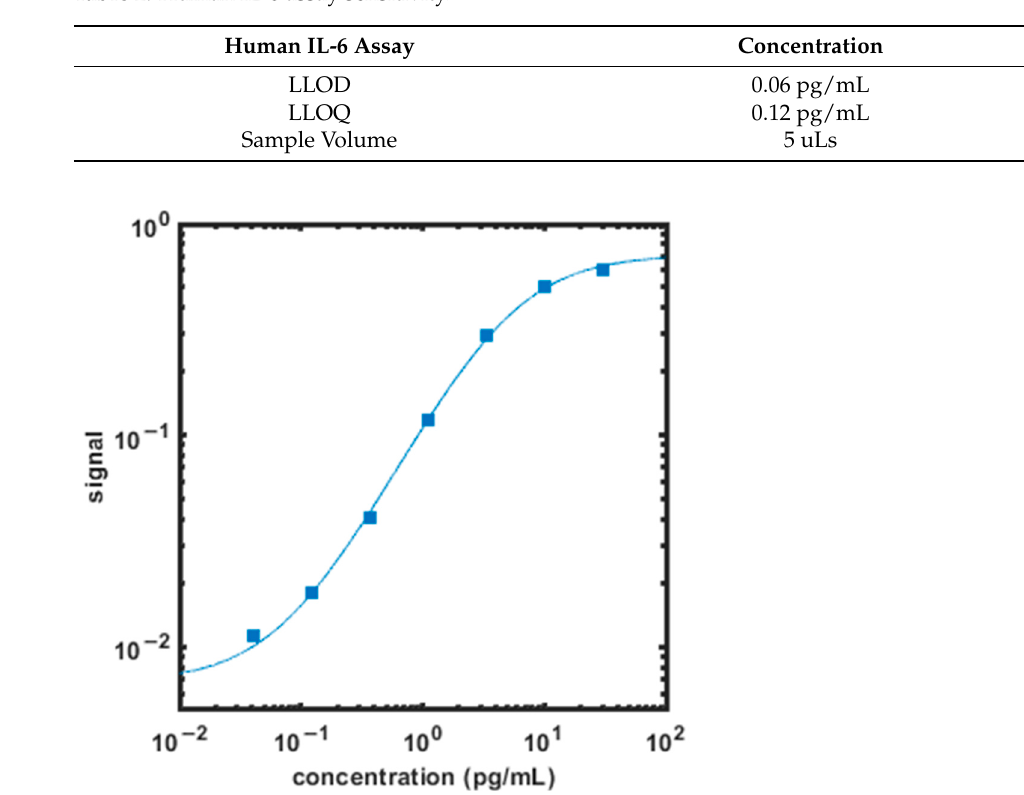
Table 2. Human IL-6 assay sensitivity.